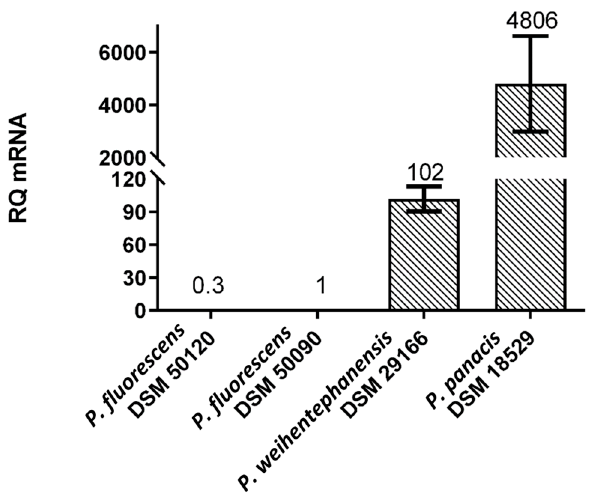
Figure 5. Relative quantity of mRNA (RQ mRNA) for each strain after sub-culturing for two hours in